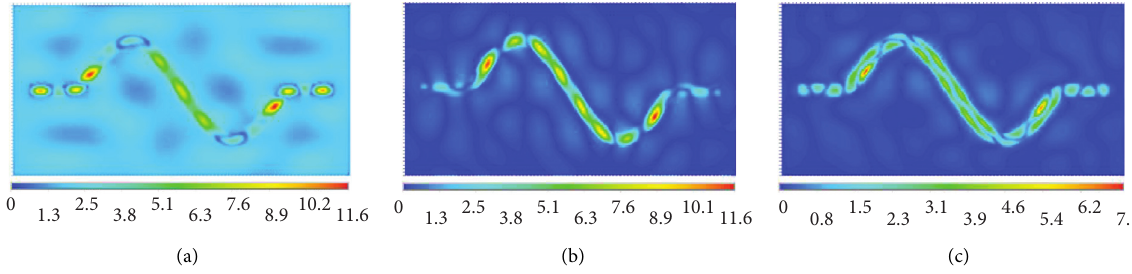
Figure 43: SV wave incident ( C